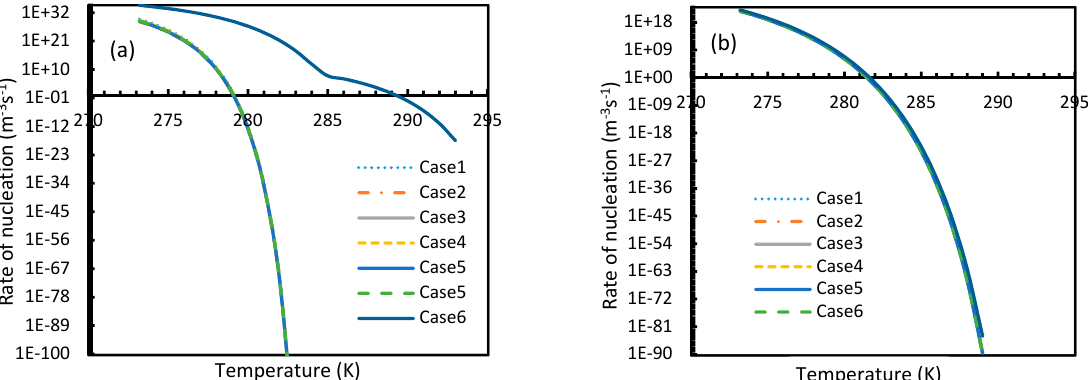
Figure 8. Profiles of nucleation rates of CO 2 ( a ) and CH 4 ( b ), under isobaric conditions with reference pressure 30 MPa. The profiles of all considered cases except Case 6 clearly show high depletions in CO 2 nucleation rate values at high operational temperatures as compared to CH 4 , which raised a fundamental concern. In addition, the point of non-differentiability is shown only by Case 6, which was similar to Figure 7.